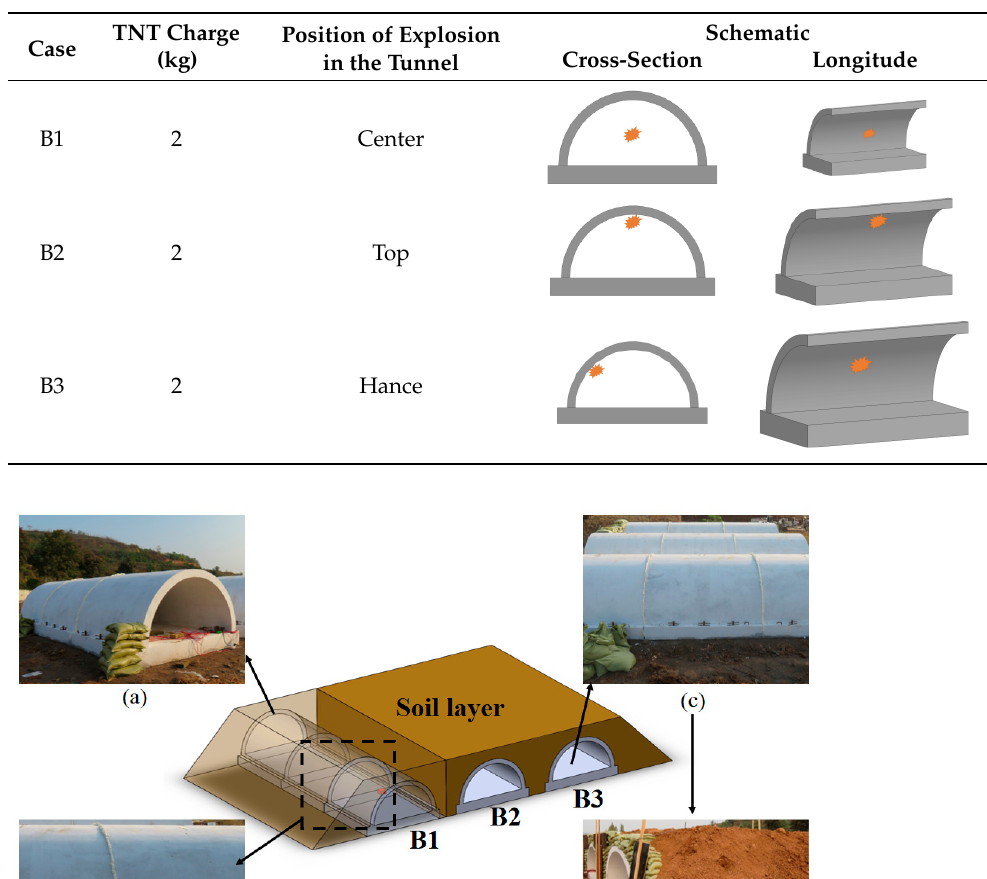
Table 2. Program of the field blast test.